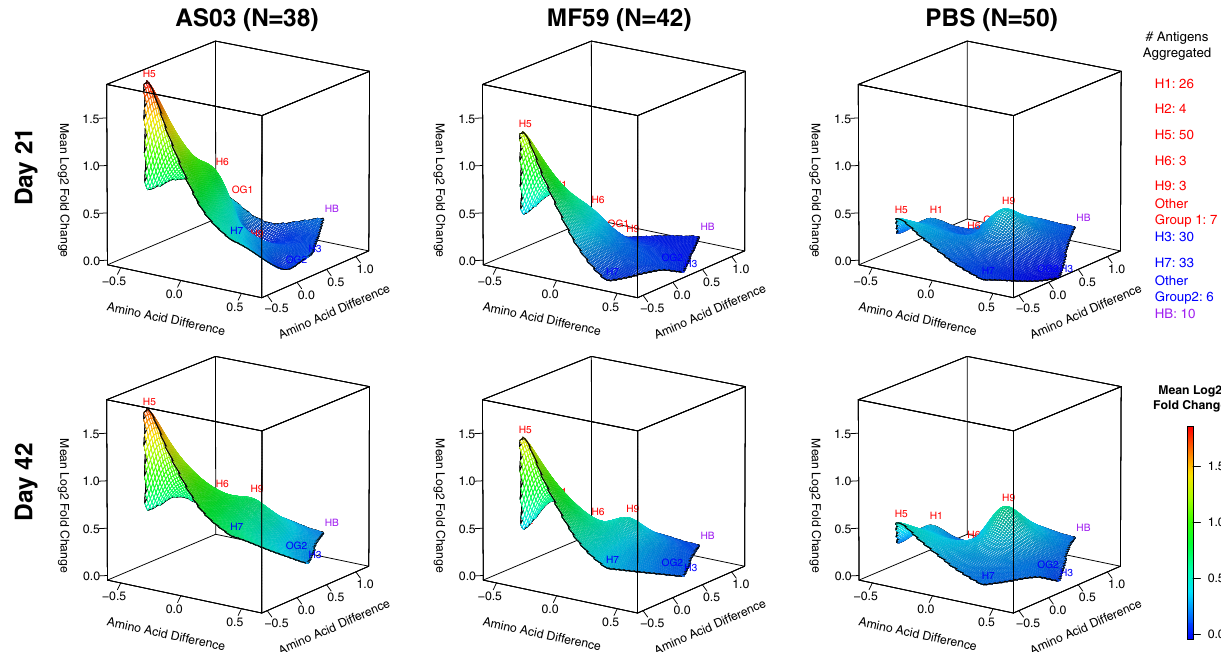
Fig. 8 Only adjuvanted vaccines elicited increased IgA antibodies against full-length H5 proteins after the fi rst dose. IgA antibody landscapes for HA0 antigens based on mean log 2 fold change relative to pre-vaccination adjusted for seasonal in fl uenza vaccination (Experiment 2). In red: Group 1 HA0 antigens, in blue: Group 2 HA0 antigens, in purple: in fl uenza B HA0. The y and x axes project antigen protein sequence divergence as measured in the number of amino acid differences between antigen proteins using multidimensional scaling. For each antigen, fi rst, the mean log 2 fold change in antibody fl uorescent intensity relative to pre-vaccination adjusted for prior seasonal in fl uenza vaccination was determined (LSMEAN). For subtypes with multiple antigens, the mean LSMEAN and MDS dimensions were used to present the results in the 3D